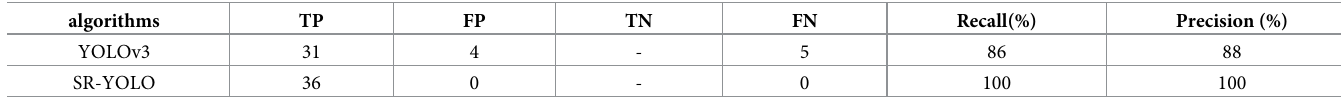
Table 7. Comparison of detection performance of YOLOv3 and SR-YOLO on remote sensing images. algorithms